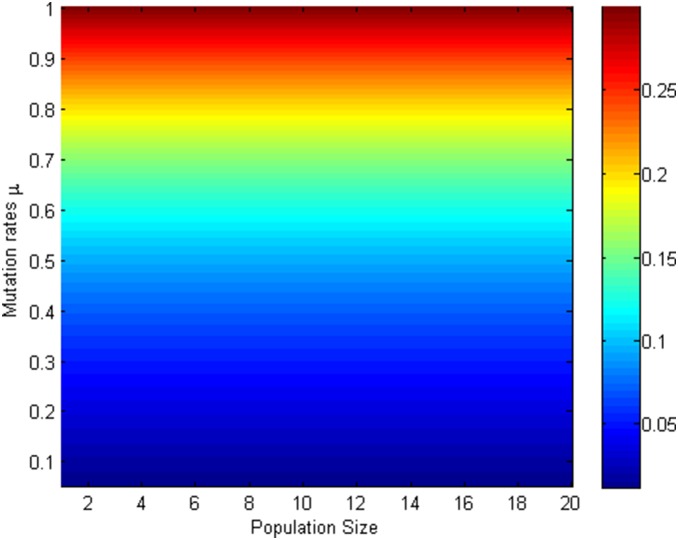
µ, m vs ρ1 with β = 0.5, b = 1.2.